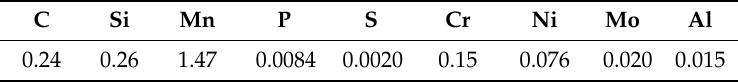
Table 1. Chemical composition of 20Mn5 steel (wt %).